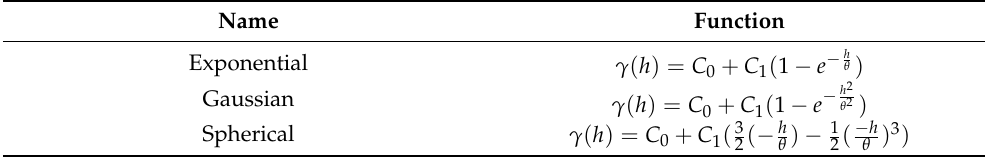
Table 1. Fitting functions of the